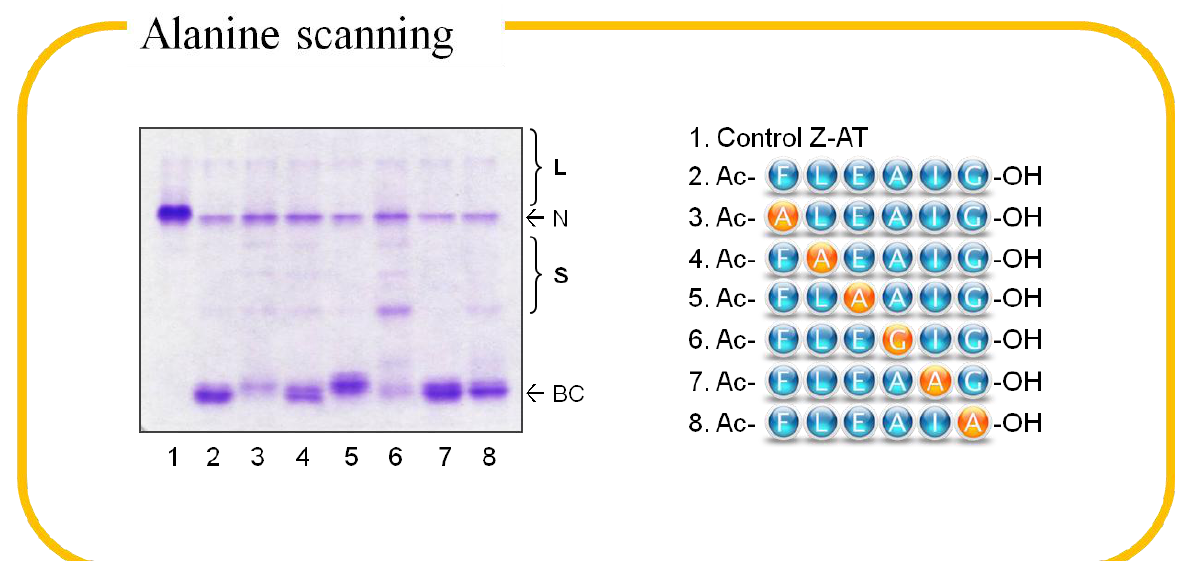
Figure 4. 8% ( w/v ) 8 M urea native-PAGE demonstrating the result of alanine scanning of the peptide Ac-FLEAIG-OH. Z α -antitrypsin (N) was incubated with a 100-fold molar 1 excess of the peptides at 37 °C for 3 days. Peptides capable of binding to the protein exhibit clear binary complexes (BC) and lesser ladder bands of the protein oligomers on the